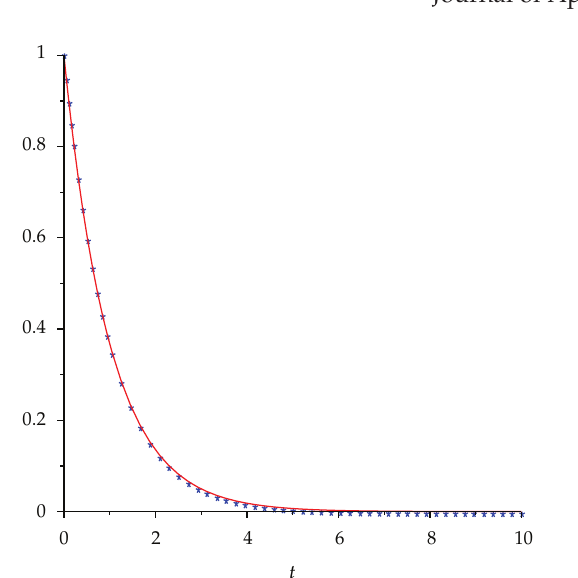
Figure 1: Graph of the exact and numerical solutions of y 1 (cid:6) x (cid:4) for N (cid:9) 13; symbols correspond to the numerical